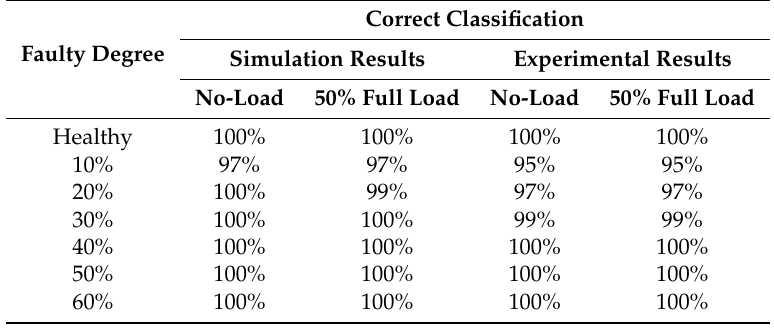
Table 4. Results of identifying fault degree by linear discriminant analysis (LDA)